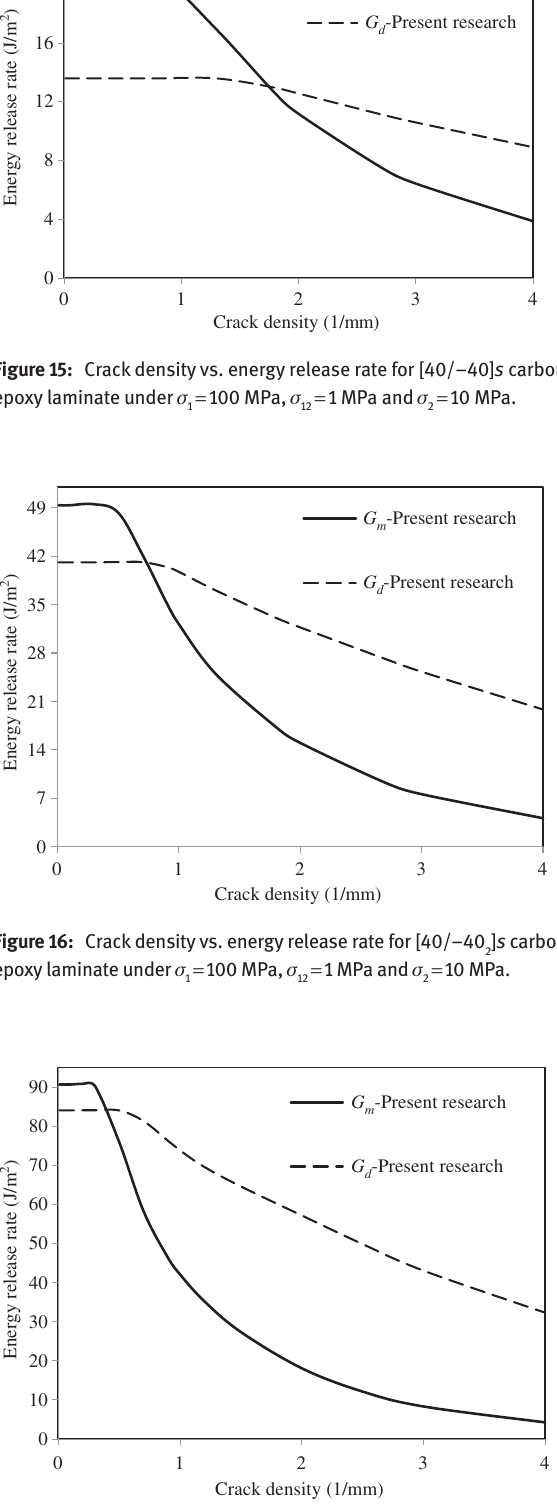
Figure 14: Crack density vs. energy release rate for [45/−45 epoxy laminate under σ